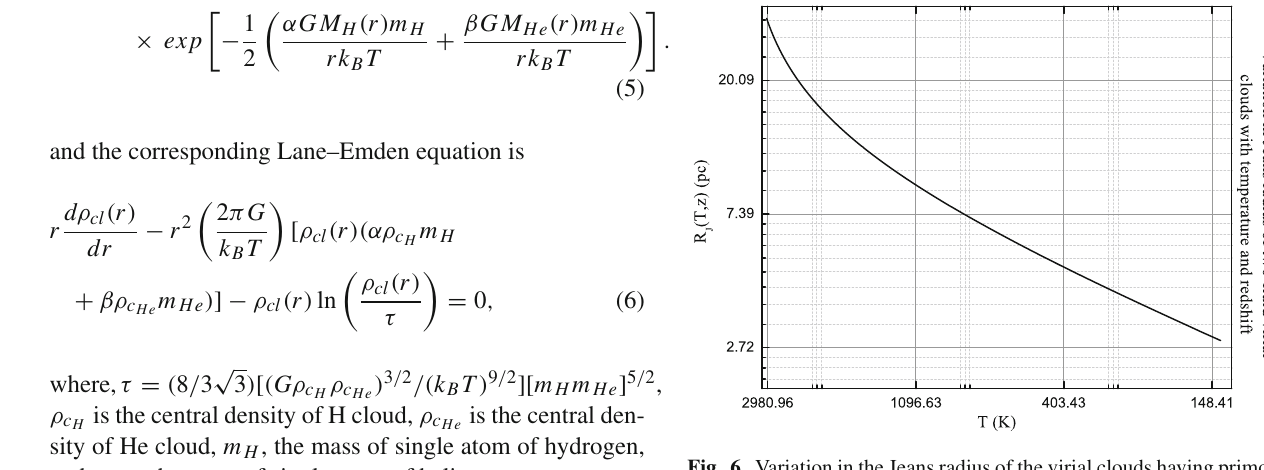
Fig. 6 Variation in the Jeans radius of the virial clouds having primor- dial fraction of H and